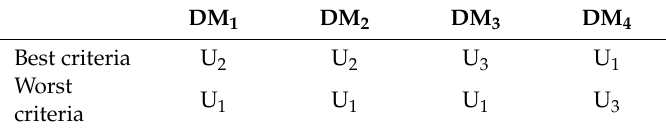
Table 6. The best and worst criteria of the main criteria.